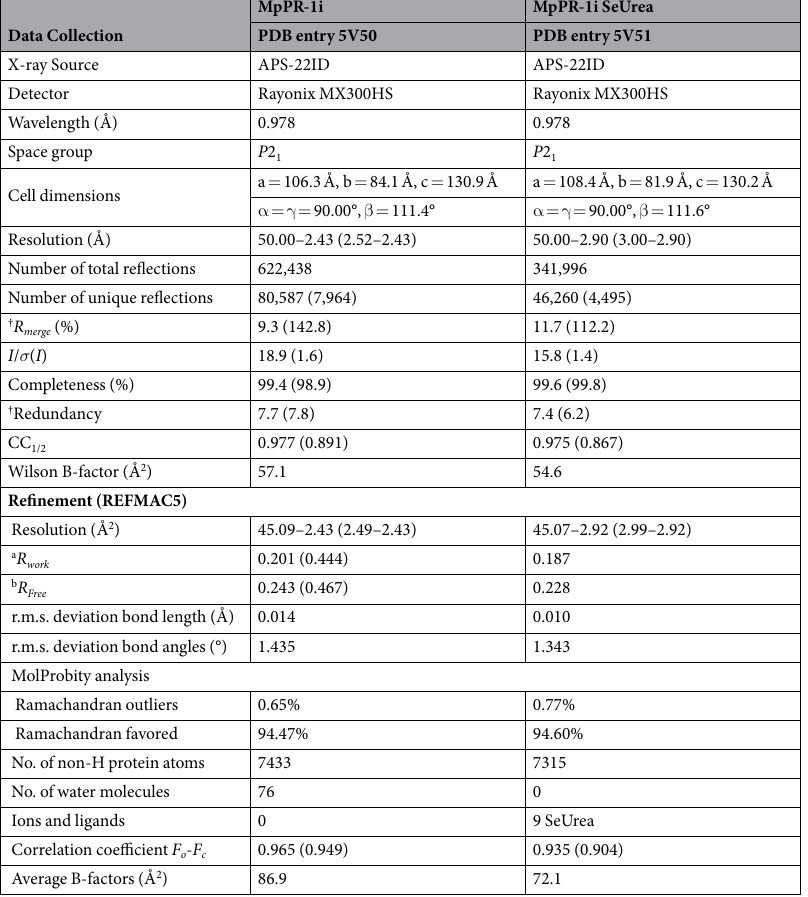
Table 1. Statistics for data collection and model